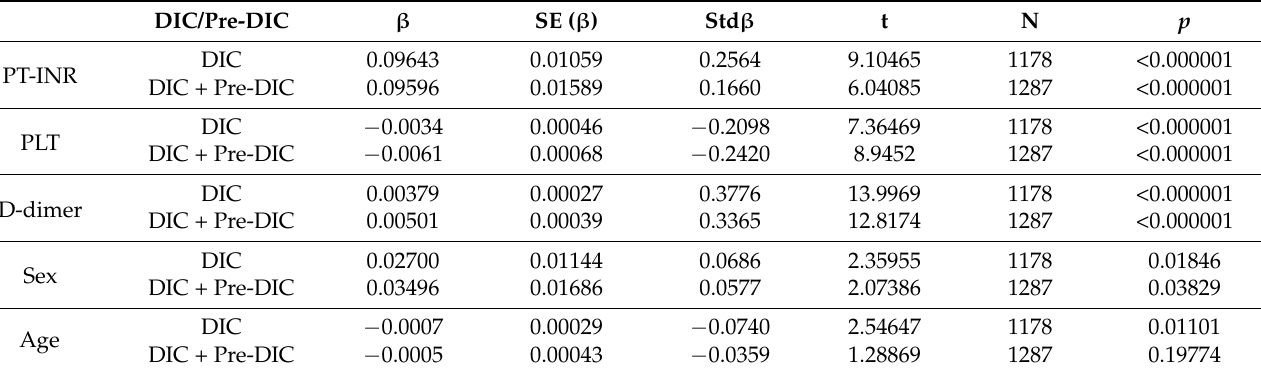
Table 2. Results of a multiple regression analysis of PT-INR, D-dimer, and platelet counts for diagnosing DIC or pre-DIC vs. non-DIC.